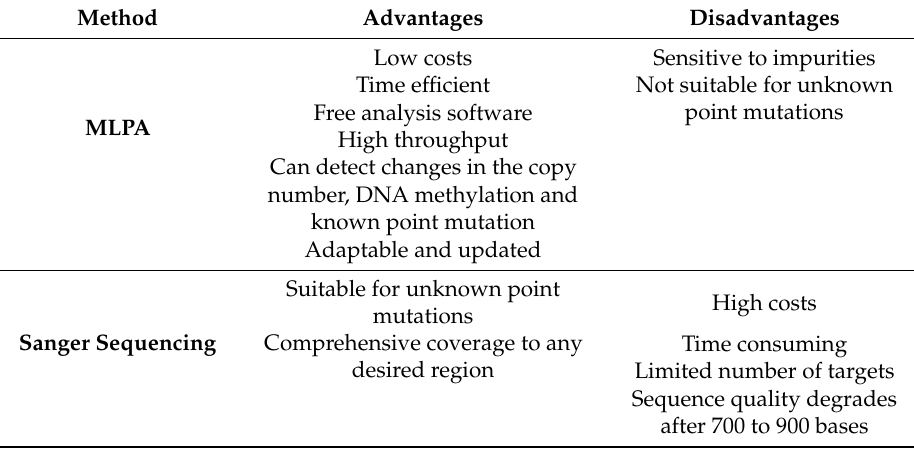
Table 3. Advantages and disadvantages for the methods used in this study